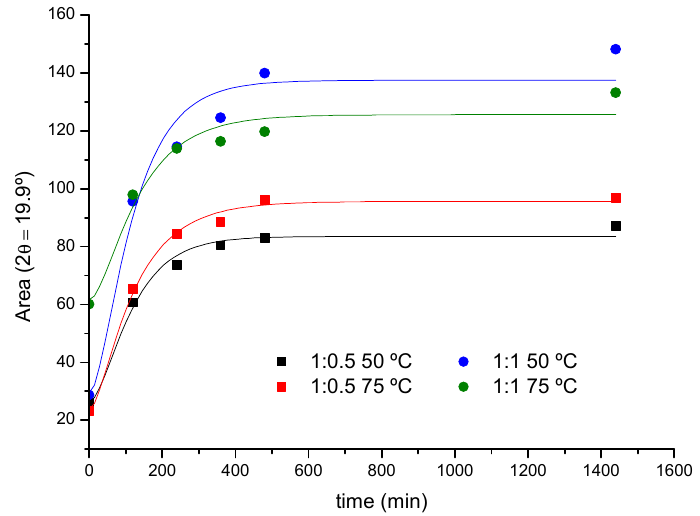
Figure 5. XRD kinetic profile for the reaction of PEG400 with α -CD (1:0.5 and 1:1 feeds, 50 and 75 °C).